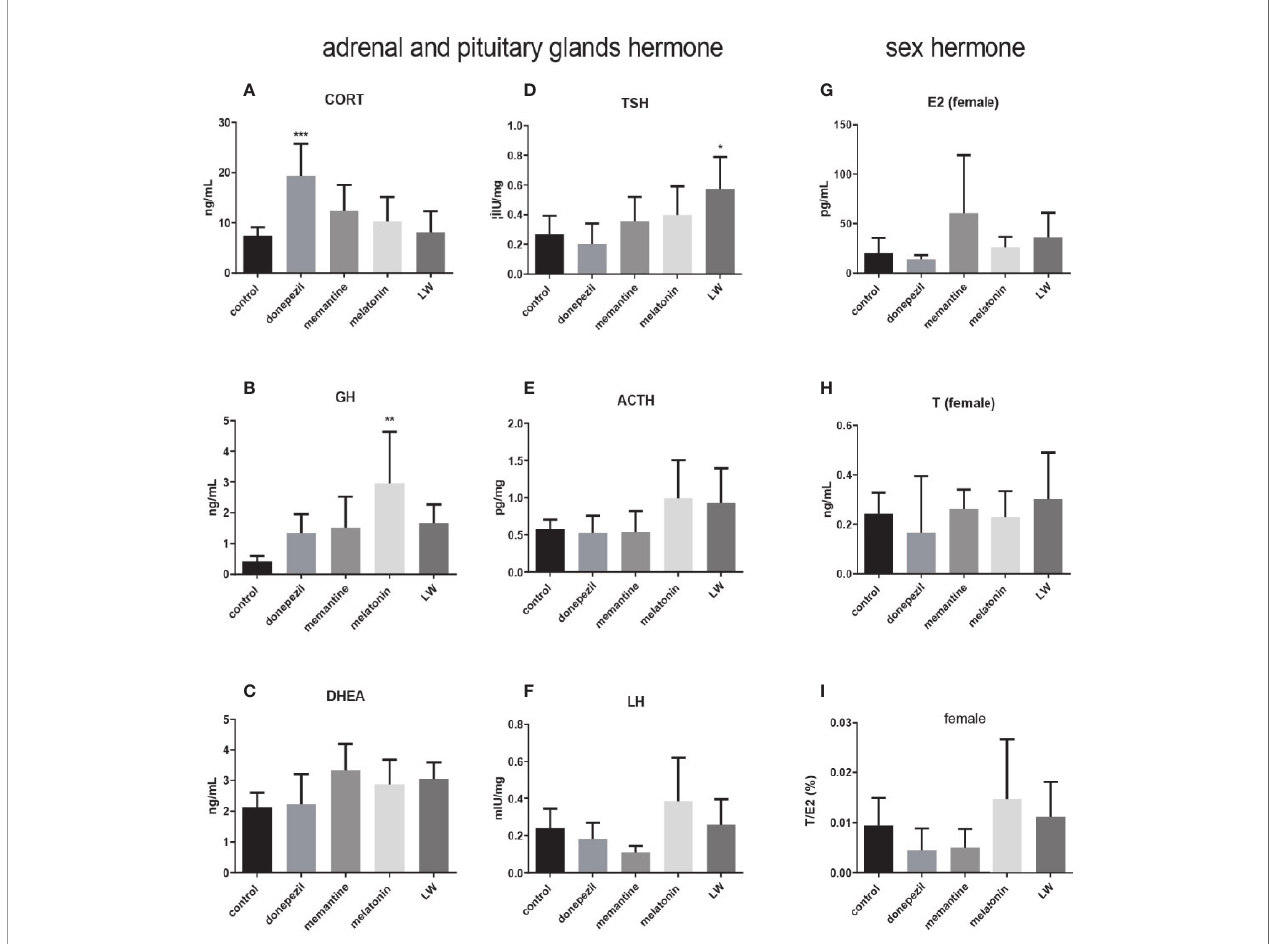
FIGURE 6 | The neuroendocrine hormone secretion in old SAMR1 mice after donepezil, memantine, melatonin, and LW administration. (A) corticosterone (CORT), (B) growth hormone (GH), (C) dehydroepiandrosterone (DHEA) in the plasma, (D) thyrotropin (TSH), (E) adrenocorticotropic hormone (ACTH), (F) luteinizing hormone (LH) in the pituitary, (G) estradiol (E2), (H) testosterone (T), (I) the ratio of T/E2 in male or female mice. * P < 0.05, ** P < 0.01, *** P < 0.001, vs control group, one-way ANOVA and Dunnett test, Kruskal-Wallis test. mean ± S.D., n=6~9(male: n=2~4, female: